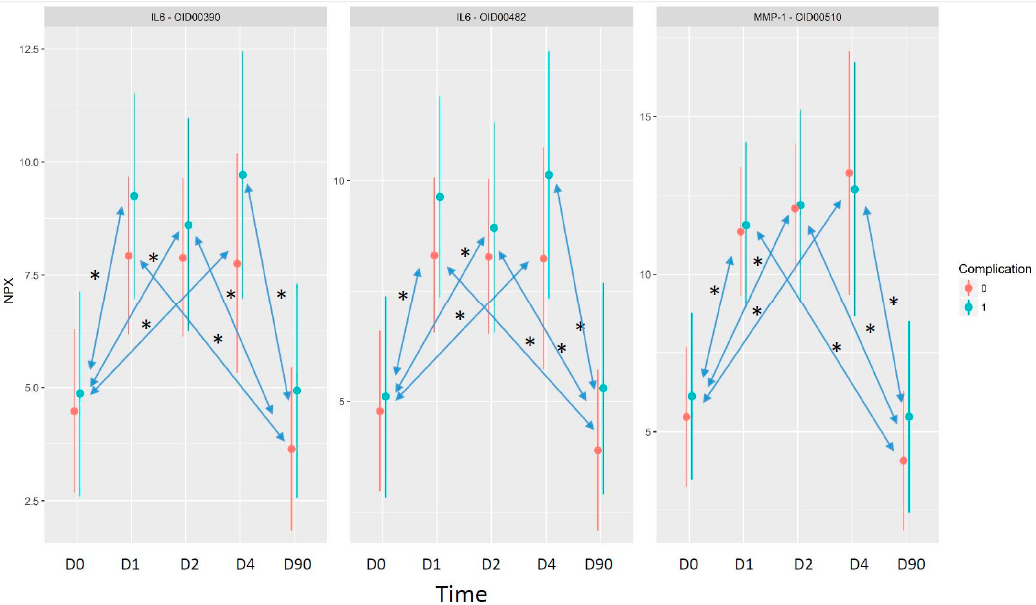
Figure 4. NPX values over the time in the case of proteins with statistically significant differences. The “ x ” axis shows the time points, and the “ y ” axis shows the mean NPX values in the cases of patients with complications (blue color) and without complications (red color) following trabeculectomy. All of the time points were compared to each other; arrows and * indicates statistical significance p < 0.05.